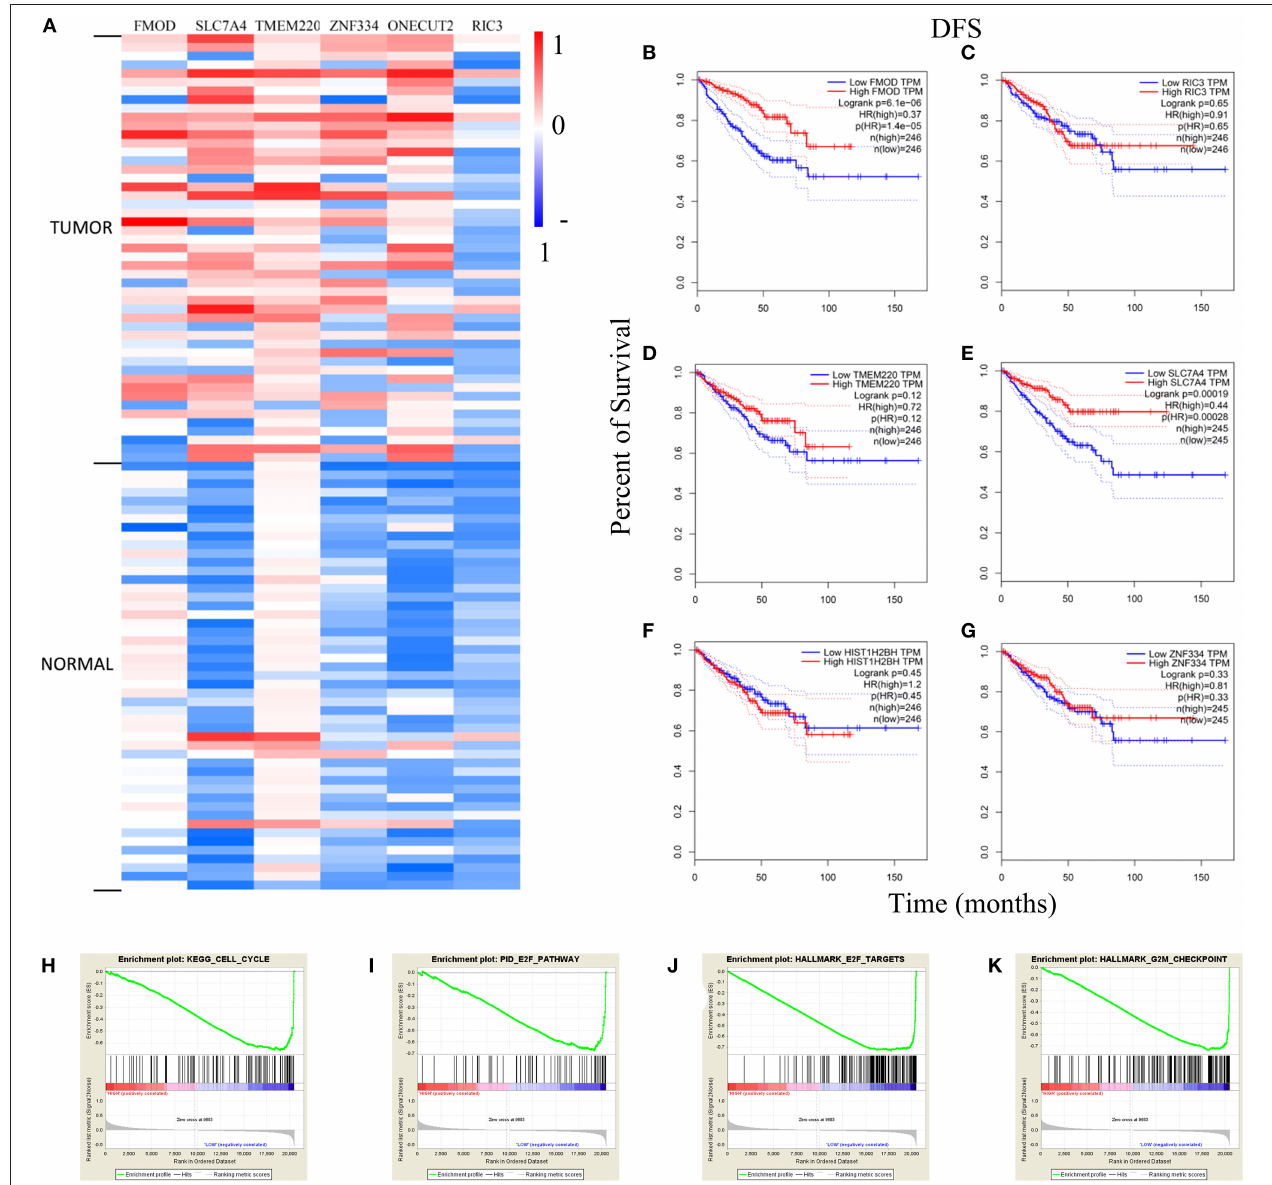
FIGURE 9 | Analysis of genes with high methylation level. (A) The differential expression of genes in tumor and normal samples. The Kaplan–Meier survival analysis curves in (B–G) demonstrated the relationship between DFS and expression level. (H–K) The GSEA curves of FMOD and SLC7A4 . DFS, disease-free survival; GSEA, Gene Set Enrichment Analysis; HR, hazard ratio; TPM, transcripts per